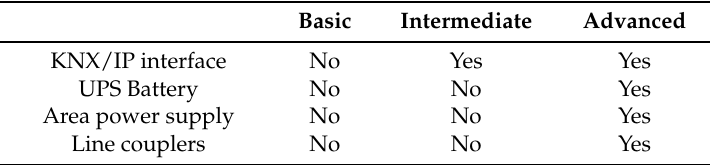
Table 8. Elements of technical alarms subsystem in common with the other systems.